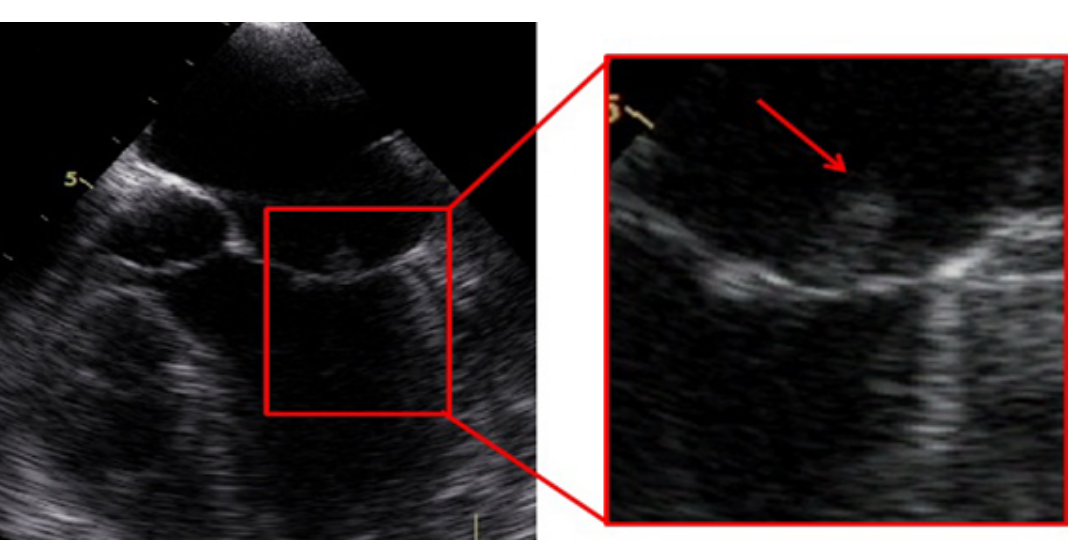
Figure 2: Vegetation on posterior mitral valve